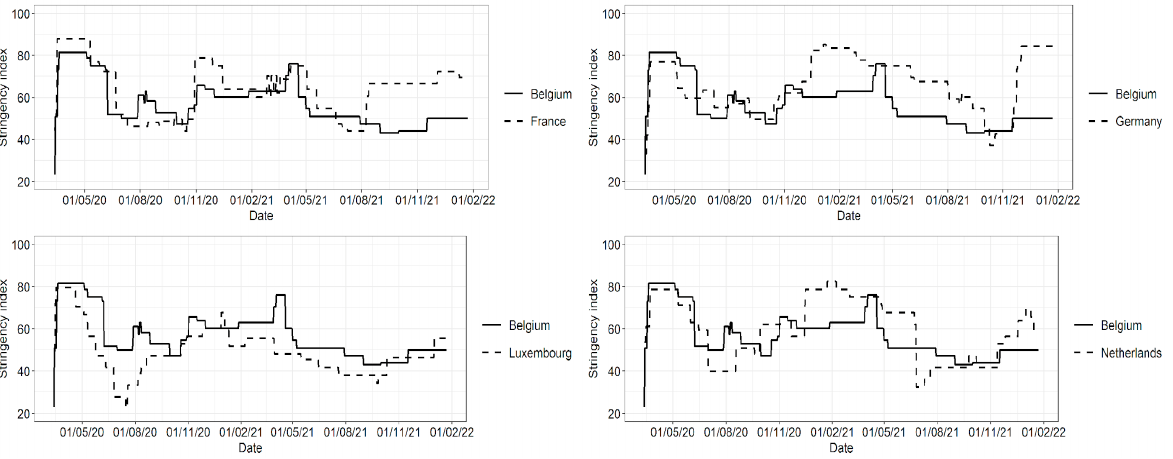
Figure 4. Stringency of non-pharmaceutical interventions (NPIs) for Belgium and its neighboring countries from the start of the COVID-19 pandemic in March 2020 until January 2022. Higher values indicate stricter NPIs in that period. The data on the travel rate (Sciensano), i.e., the number of weekly incoming travelers per 100 inhabitants, and the positivity rate of incoming travelers doing a PCR test from January 2021 onwards are shown in Figure 6. Note that there are no reference data from before the pandemic. In Belgium, a ban on non-essential travel was in place from 27 January 2021 until 19 April 2021, leading to relatively low travel rates during this period.